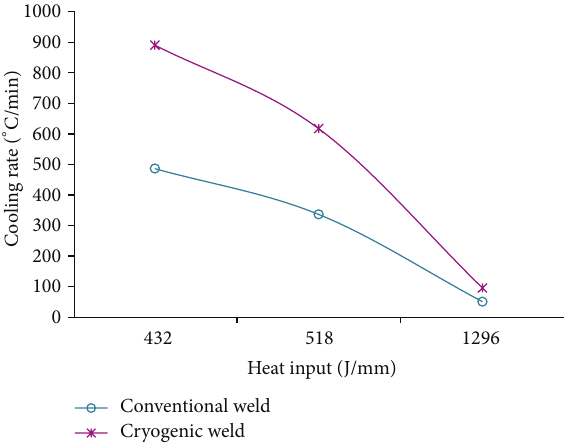
Figure 5: Combined effect of heat input and cooling conditions on the cooling rate from 1500 to 800 ∘ C at a point in the HTHAZ adjacent to the weld interface.